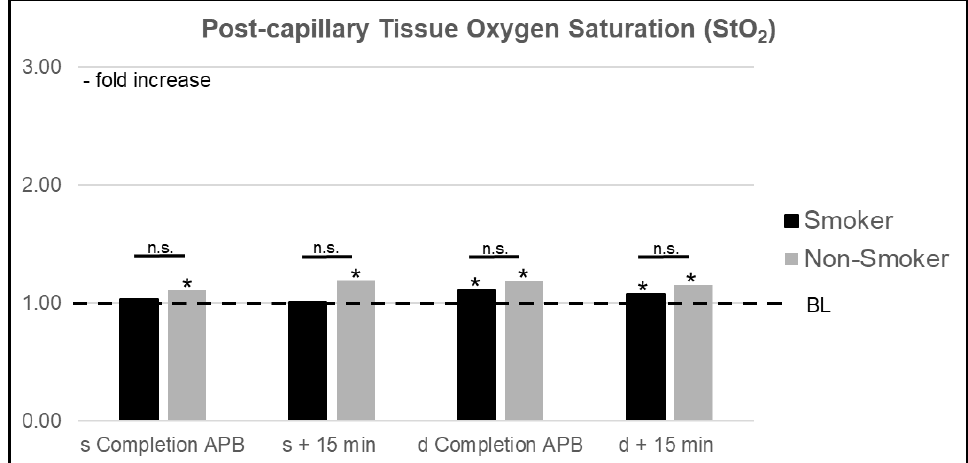
Figure 6. Relative increase of mean superficial (s) and deep (d) post-capillary oxygen saturation (StO 2 ) in smokers vs. nonsmokers right after completion of the axillary plexus blockade (APB) and after an additional 15 min. BL = baseline value, n.s. = nonsignificant, * significant change compared to BL.